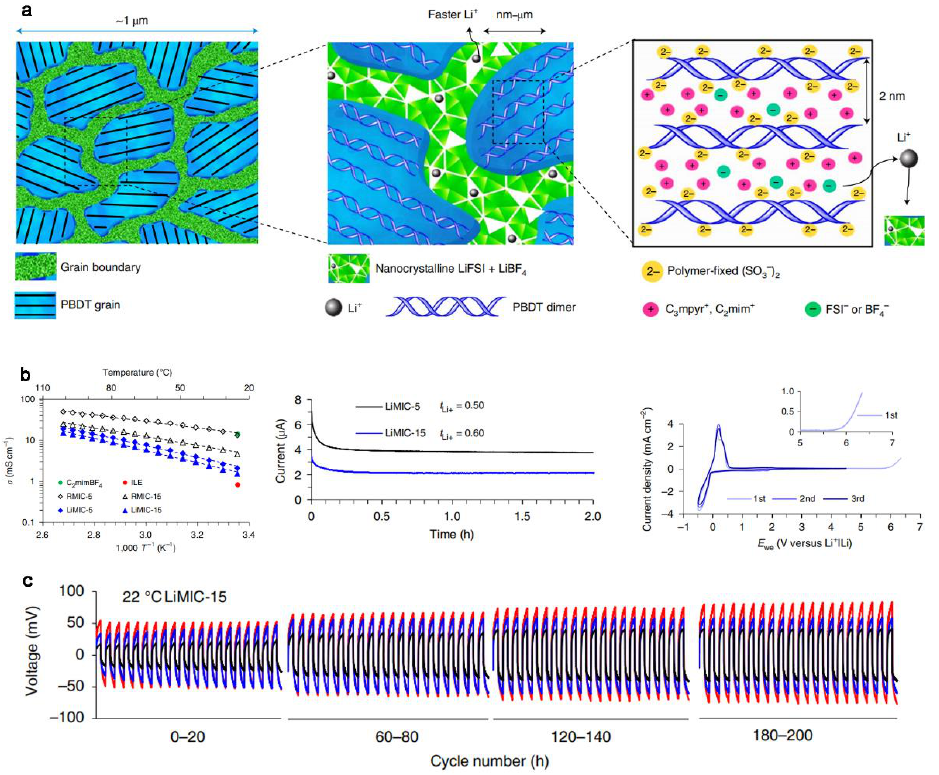
Figure 3. ( a ) Li-loaded molecular ionic composite (LiMIC) can form a conductive network support- ing fast Li + transport. ( b ) Temperature-dependent conductivity of MICs (RMICs) and LiMICs,